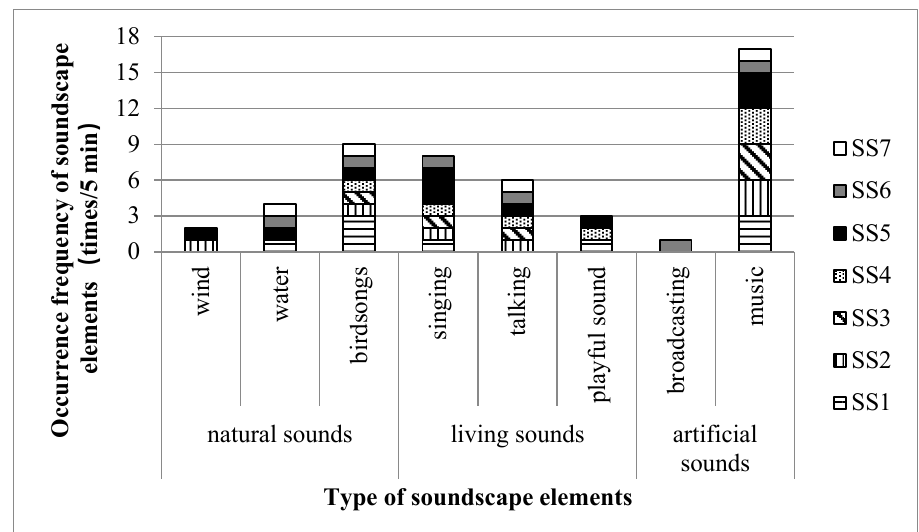
Figure 3. Frequency of soundscape elements.